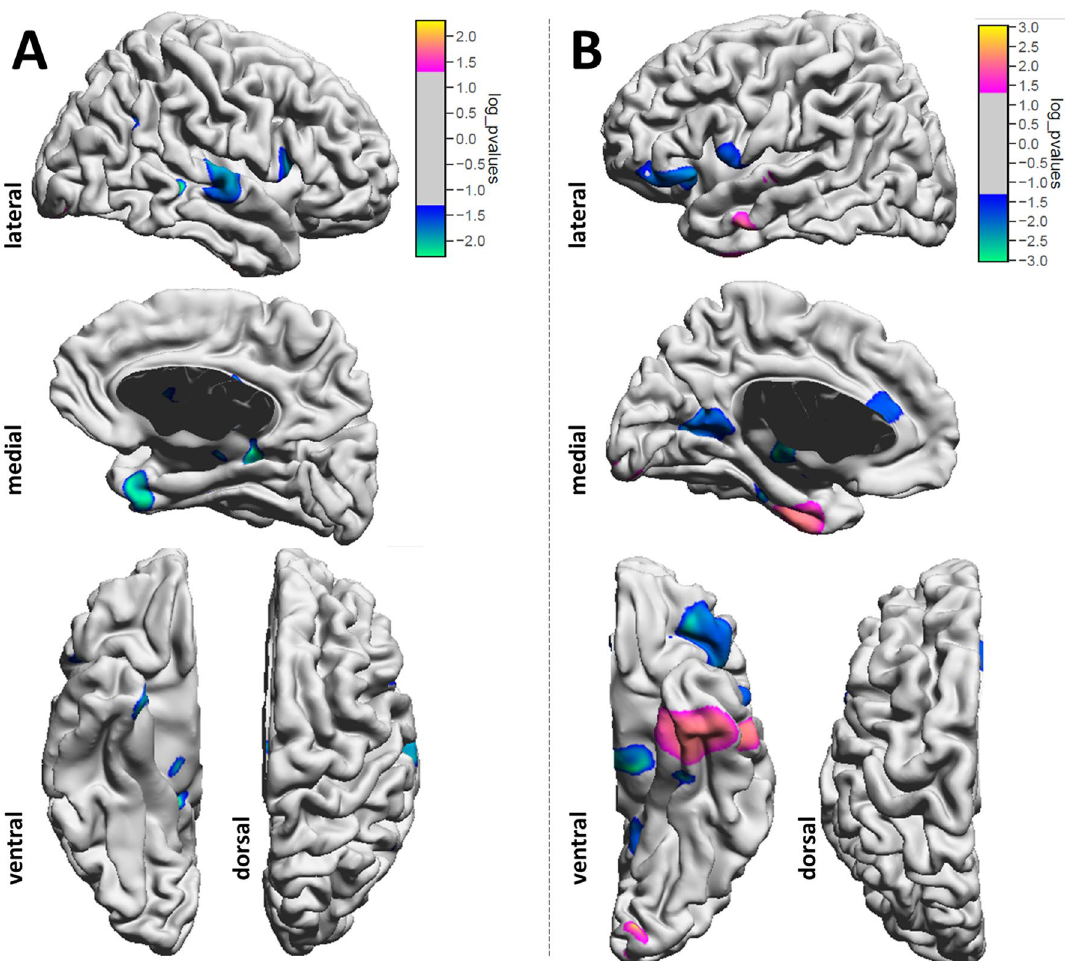
Figure 1. Whole-brain vertex-based statistical maps (corrected for TIV) indicated volumetric changes covering ipsilesional ( A ) and contralesional ( B ) frontal (e.g., opercular part of inferior frontal gyrus), temporal (e.g., medial temporal gyrus, fusiform gyrus) and mesial (e.g., cingulate gyrus and precuneus) structures. Notably, p value is not corrected for multiple comparisons. Results did not withstand FDR-based multiple comparison